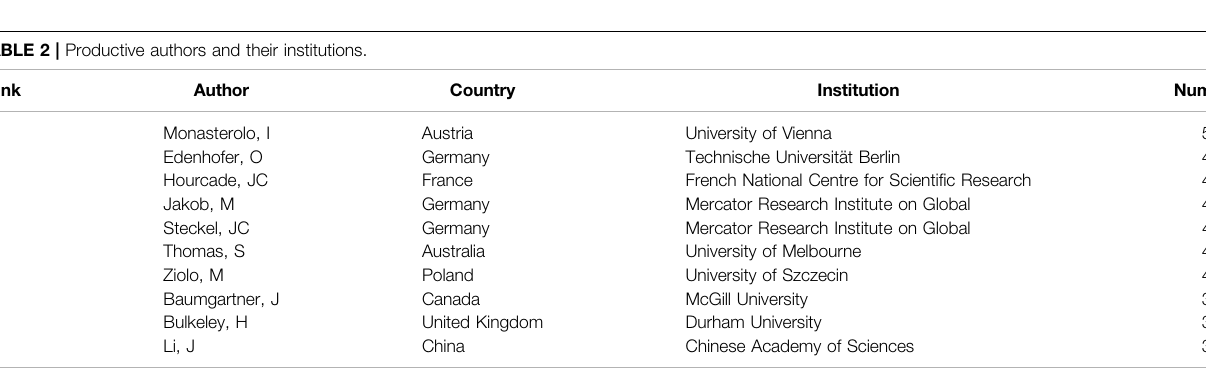
TABLE 2 | Productive authors and their